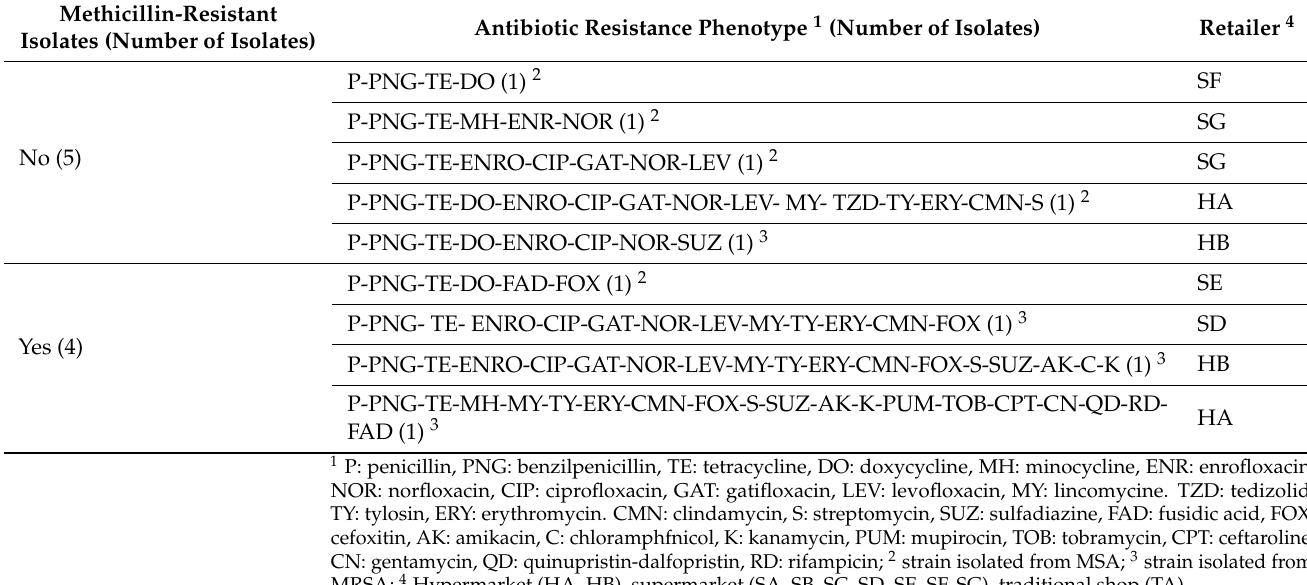
Table 9. Antimicrobial resistance phenotype of S. aureus from turkey samples.